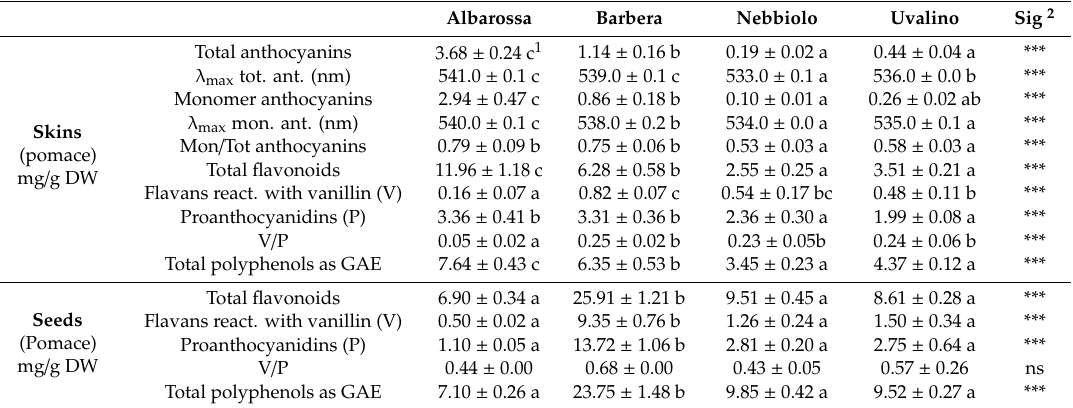
Table 5. Phenolic composition in mg / g (DW) of the skin and seed extracts obtained from the fermented pomace of the four studied cultivars, and ANOVA